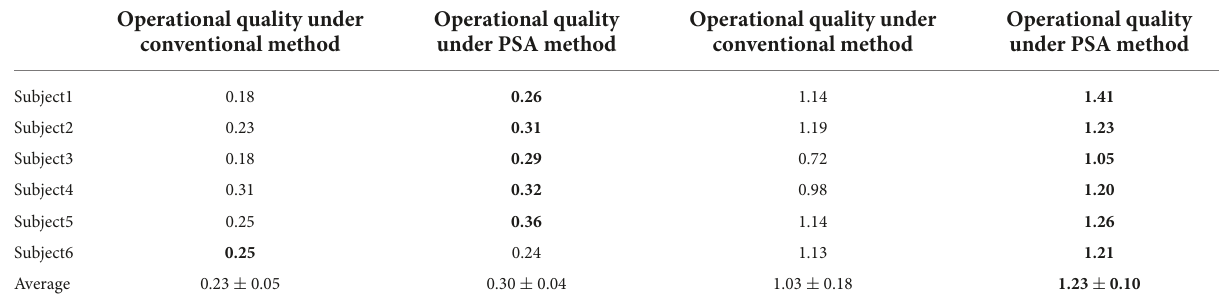
TABLE 2 Operational quality of all